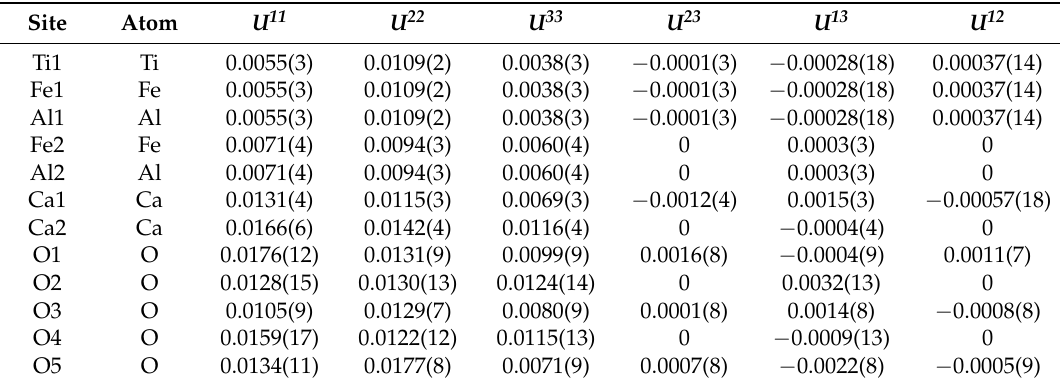
Table 7. Anisotropic displacement parameters (Å 2 ) for